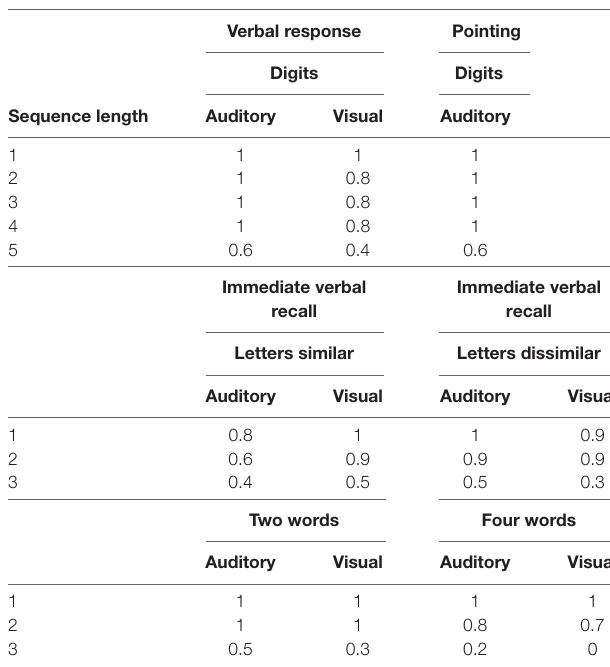
tabLe 2 | Investigation of phonological loop functions.